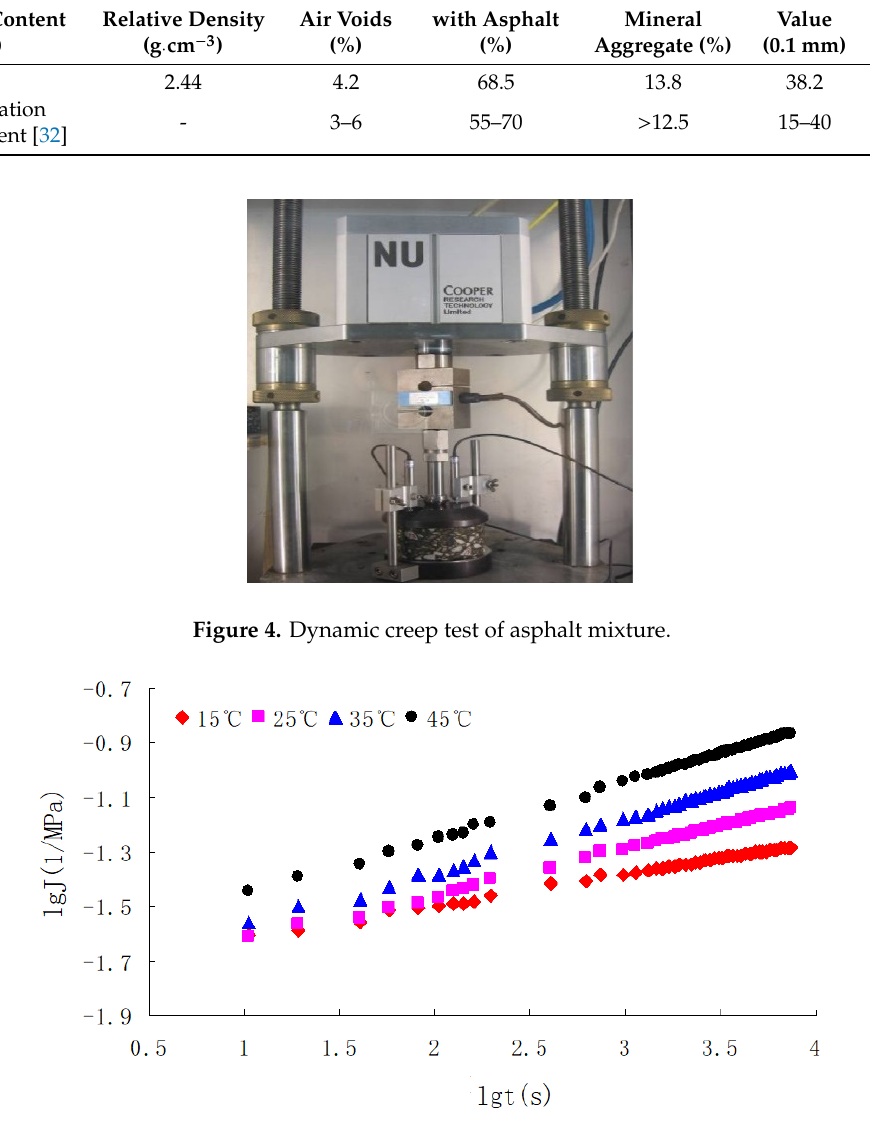
Figure 5. Double logarithmic curve of asphalt mixture between creep compliance and load time.